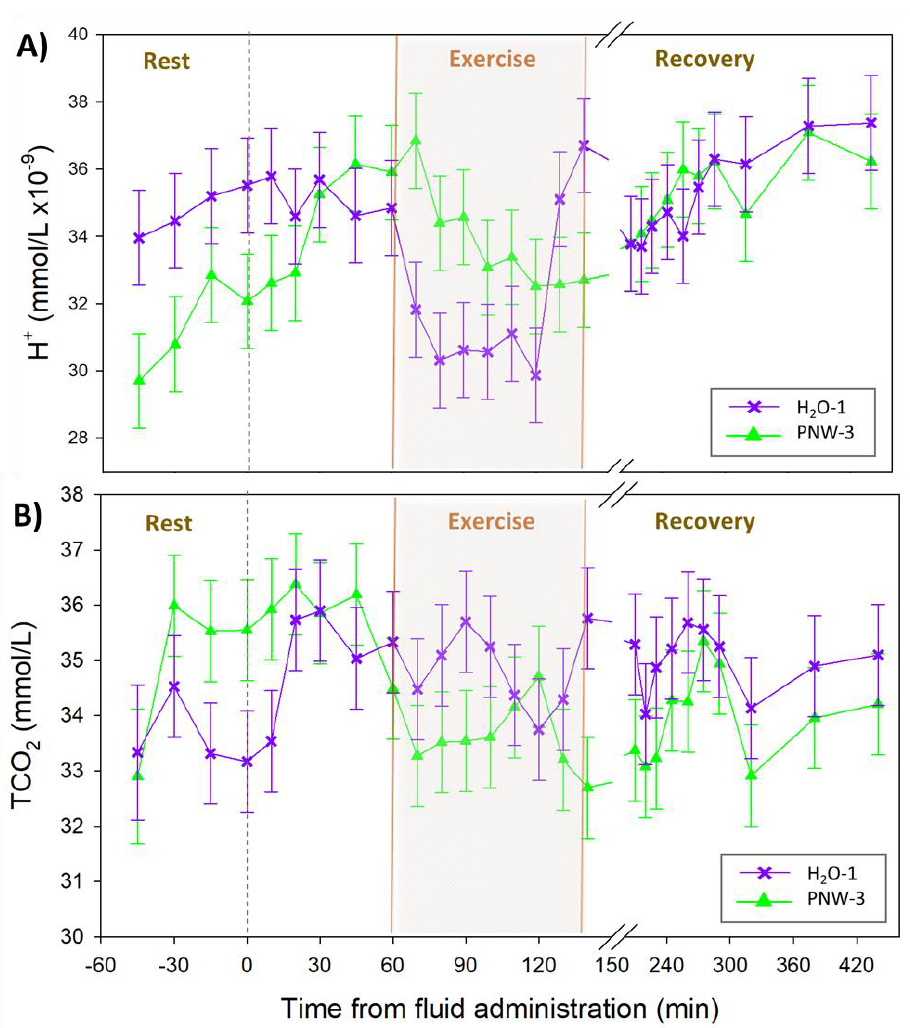
Figure 3. The time courses of plasma dependent acid-base variables at rest, during prolonged submaximal exercise, and up to 4 h of recovery. ( A ) hydrogen ion [H + ] and ( B ) total carbon dioxide [TCO2] for n = 4 horses. In randomized crossover design horses were administered either 3L of a balanced hypotonic oral electrolyte solution (PNW-3), or 1L of water alone (H 2 O-1), 60 min before they exercised on a treadmill at 30% of peak VO 2 until voluntary fatigue. Values are mean ± SE. There were no significant differences over time or between groups.